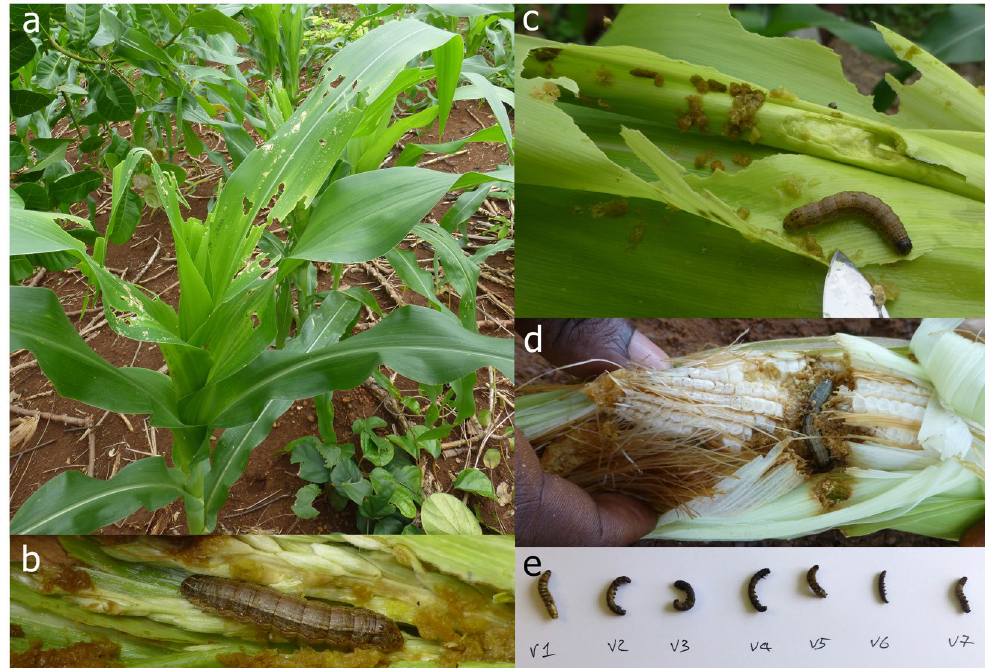
Figure 1. Field observations. Images of ( a ) damage, ( b – d ) live larvae and ( e ) preserved larvae from field work. This type of material alone did not justify the identification of Spodoptera frugiperda as a new pest species for Ghana, and so molecular methods were needed. (All images: Jayne